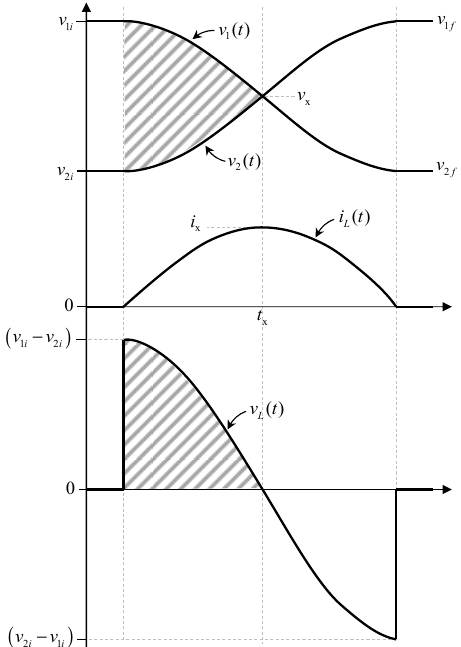
Figure 23. Voltage and current signals during the resonant charge interchange. The current through the inductor starts rising when the switch closes, at an instanta- neous rate of ( v 1 i − v 2 i )/ L ; the current of the inductor stops rising when both capacitors have the same voltage, that is, the moment in which the inductor has its maximum current I max , see Figure